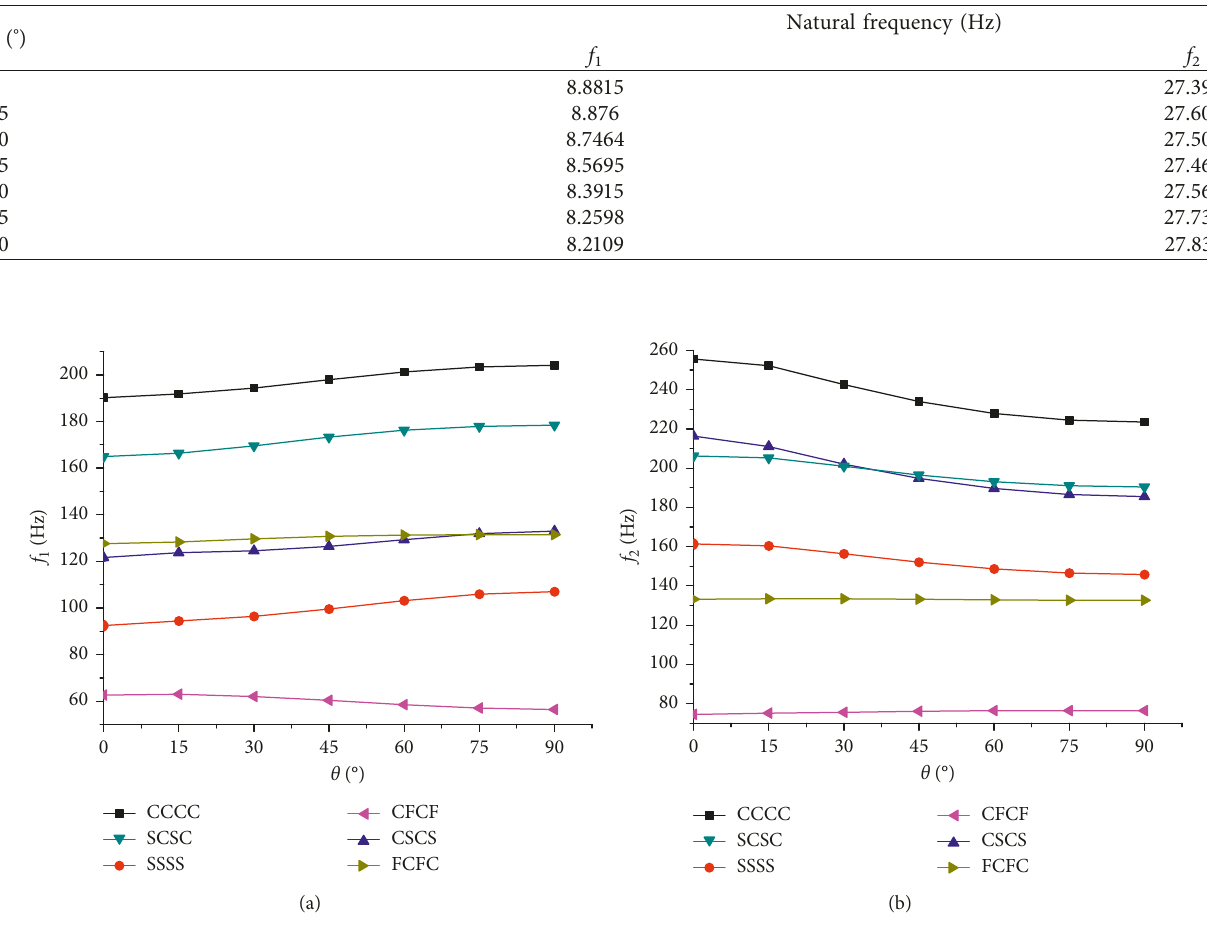
Figure 8: Variations of the natural frequencies of a rectangular plate supposed differently with various θ